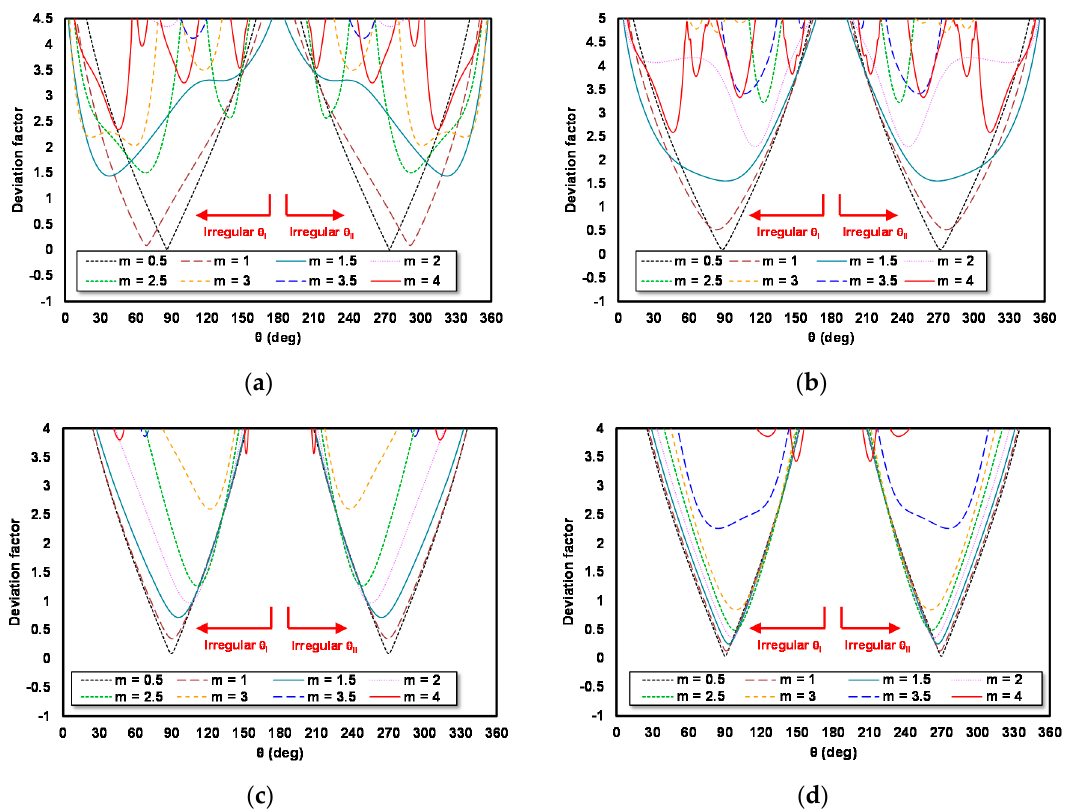
Figure 7. Deviation factor as the θ function for ( a ) scheme B1; ( b ) B2; ( c ) B3; and ( d ) B4.